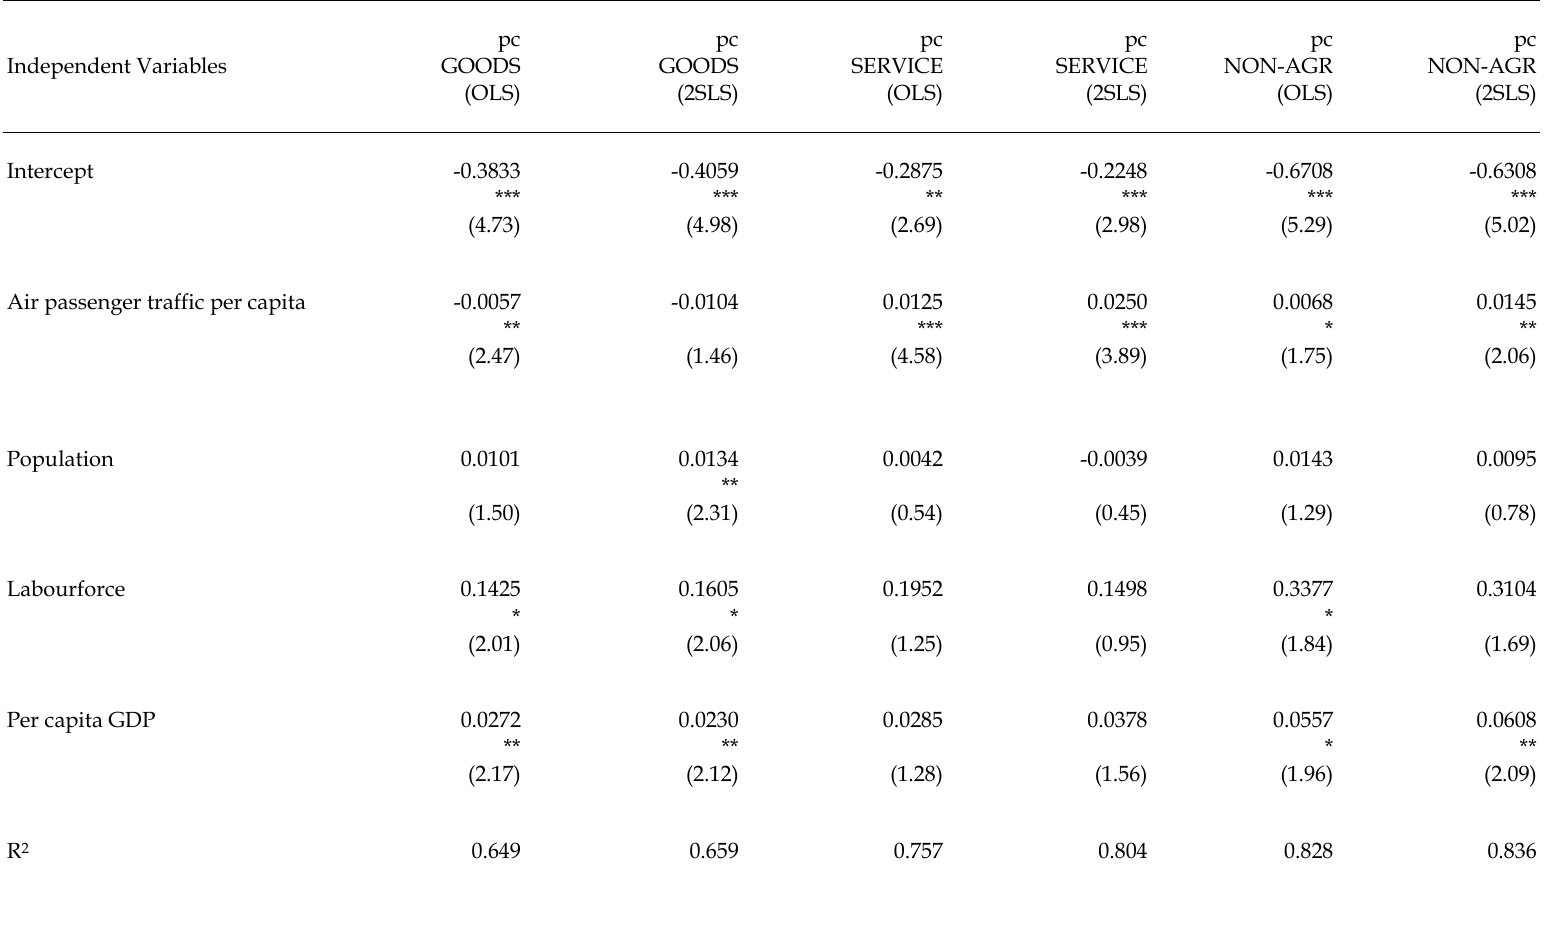
Table 4. Regression Results for Aggregate